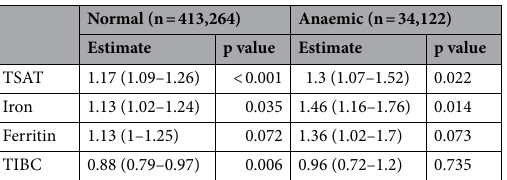
Table 3. Odds ratios for each PRS in the anaemic and non-anaemic population in UK Biobank.